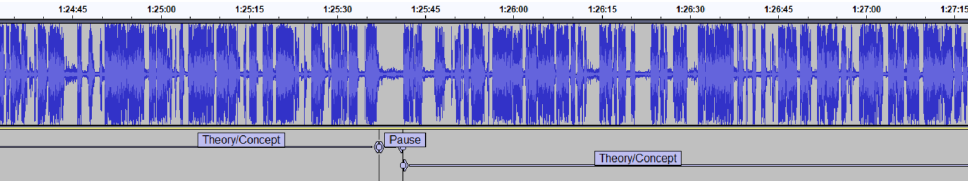
Figure 7. Audio sample of a Pause segment between Theory segments. Table 6. Transcription of Figure